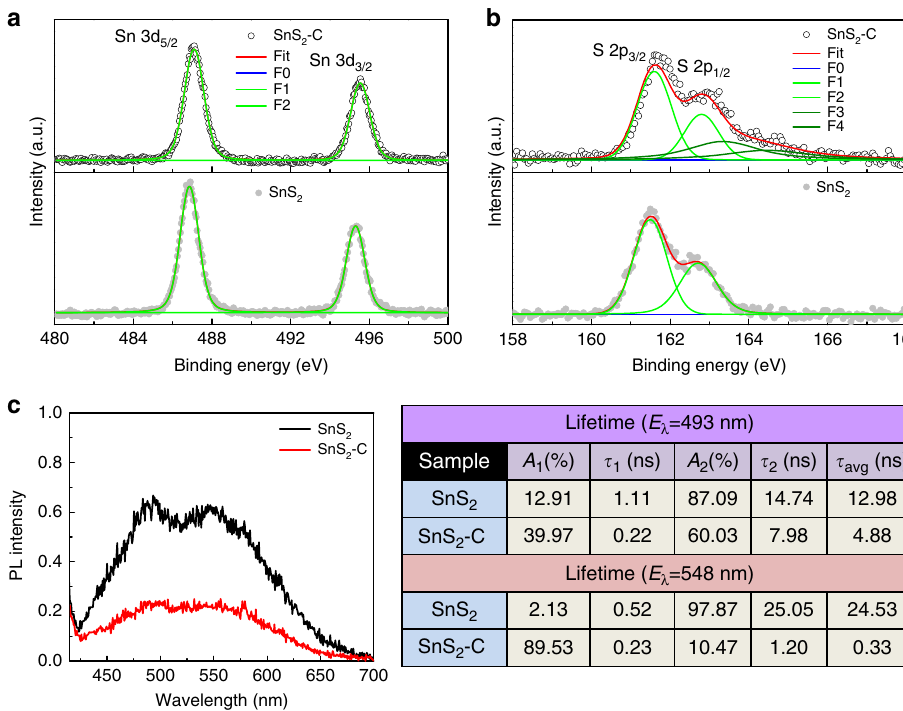
Fig. 3 Electronic structure analysis of SnS 2 -C and SnS 2 . a High-resolution XPS Sn 3d spectra of SnS 2 -C and SnS 2 . b High-resolution XPS S 2p spectra of SnS 2 -C and SnS 2 . c Normalized PL spectra of SnS 2 -C and SnS 2 and the summary table of TRPL slow, fast, and average lifetime calculated at both 493 and 548 nm